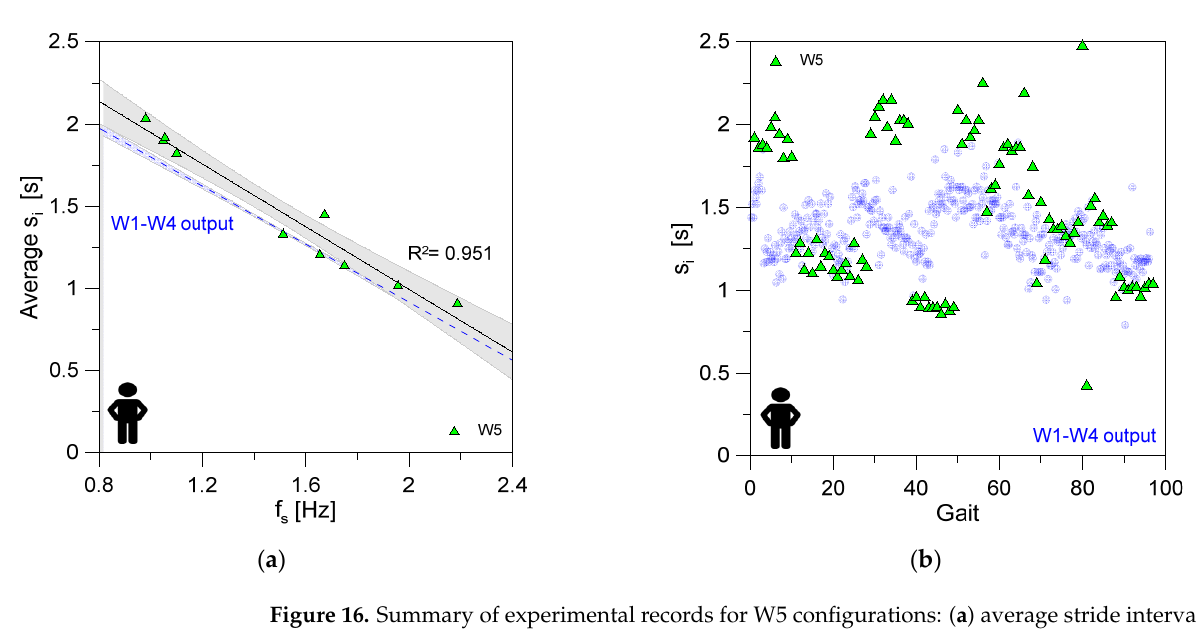
Figure 16. Summary of experimental records for W5 configurations: ( a ) average stride interval, and ( b ) stride interval variation. The 95% confidence interval is shown in grey.